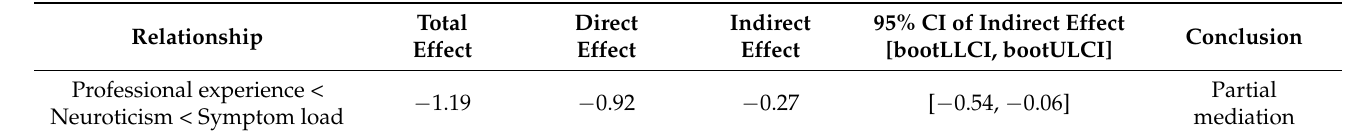
Table 5. Indirect, direct, and total effects of length of professional experience as an EMS physician in years on symptom load caused by second victim experience.